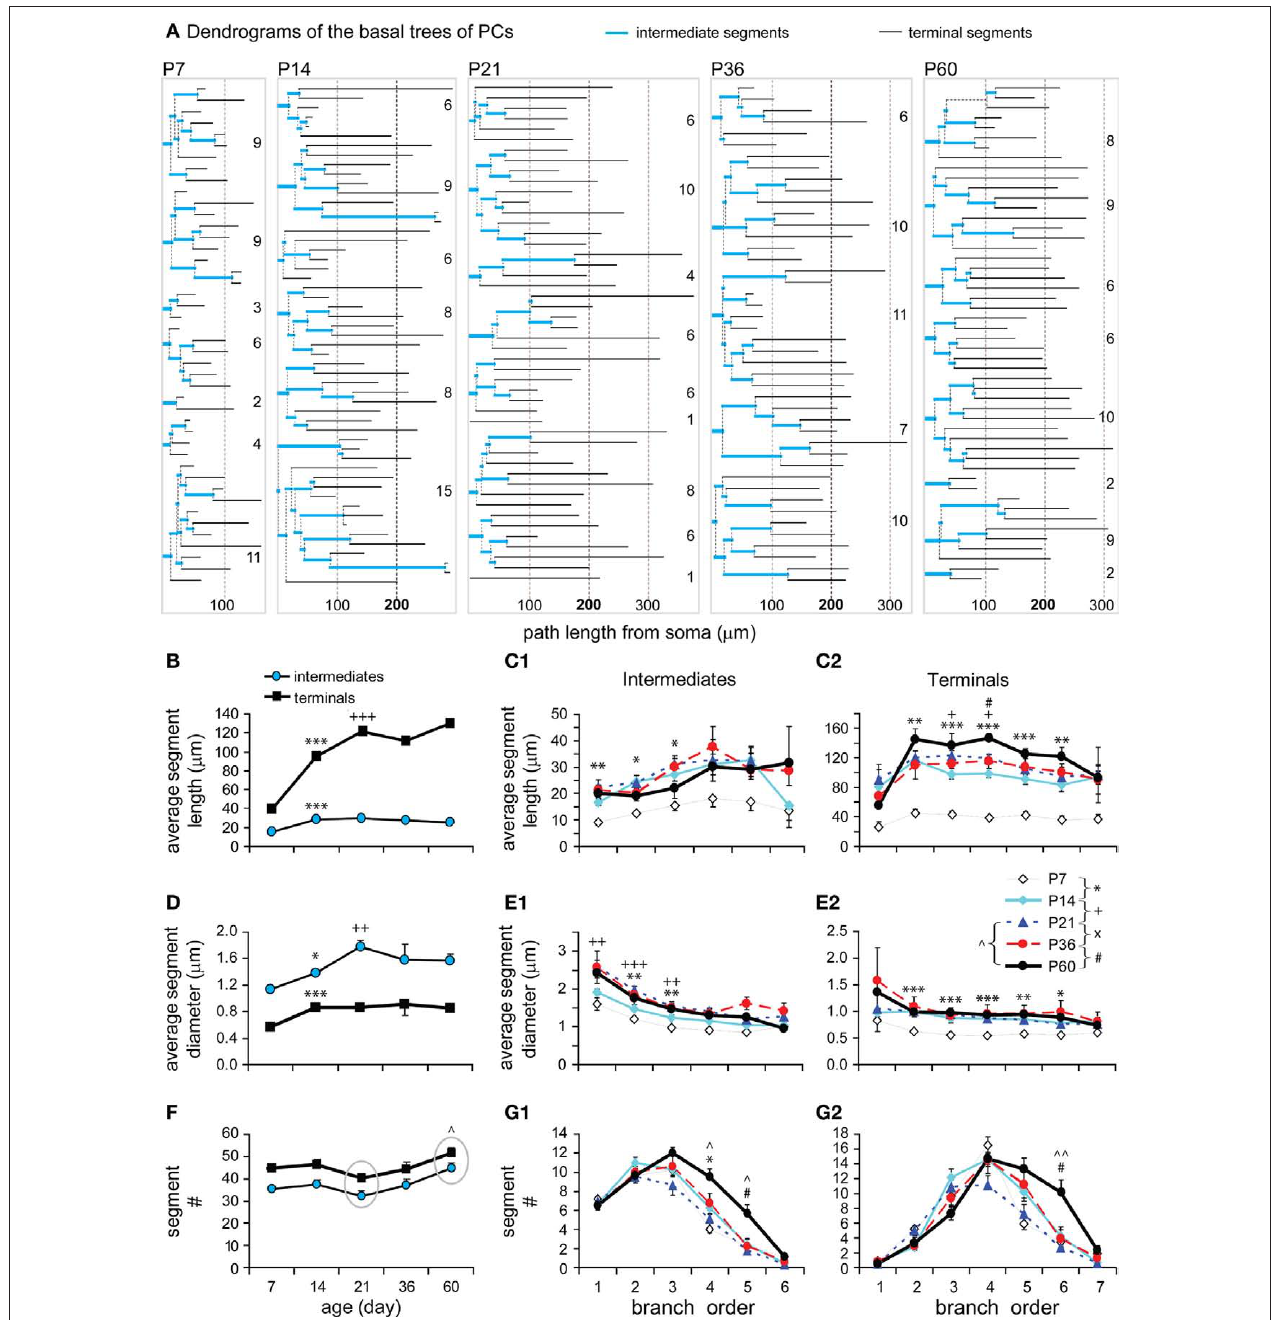
intermediate and terminal segments versus age [same cells as in (B) ]. Before reaching a constant level, a significant increase in thickness was tested from P7 to P14 and from P14 to P21 in intermediates and from P7 to P14 in terminals. (e1) The intermediate segment diameter significantly increased on the first to third orders from P7 to P14 and from P14 to P21. (e2) The terminal segment diameter significantly increased on the second to sixth orders from P7 to P14. (F) Average number of intermediate and terminal segments versus age [same cells as in (B) ]. A significant increase in the total segment number was tested between P21 to P60. (g1) The intermediate segment number significantly increased on the fourth orders from P7 to P14, on the fourth and fifth orders from P21 to P60, and on the fifth order from P36 to P60. (g2) The terminal segment number significantly increased on the sixth orders from P21 to P60, which is also significant from P36 to